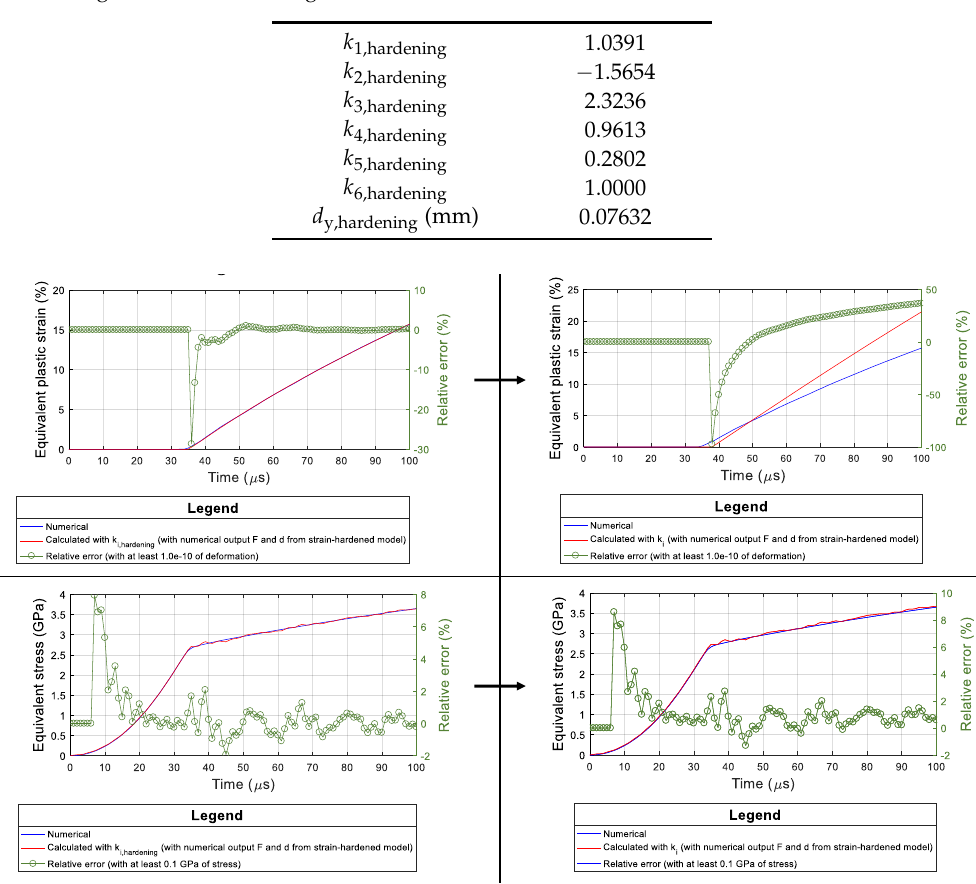
Figure 7. Comparison of quantities ( ε eq,num and σ eq,num ) averaged in the ligament of a numerical simulation involving a sample with strain-hardening to the quantities ( ε eq,calc and σ eq,calc ) obtained by applying the processing method to the numerical force and displacement extracted from the numerical simulation. On the left part, the processing method is based on 𝑘 𝑖,hardening parameters (Table 8). On the right part, the processing method is based on parameters 𝑘 𝑖 of Table 6.